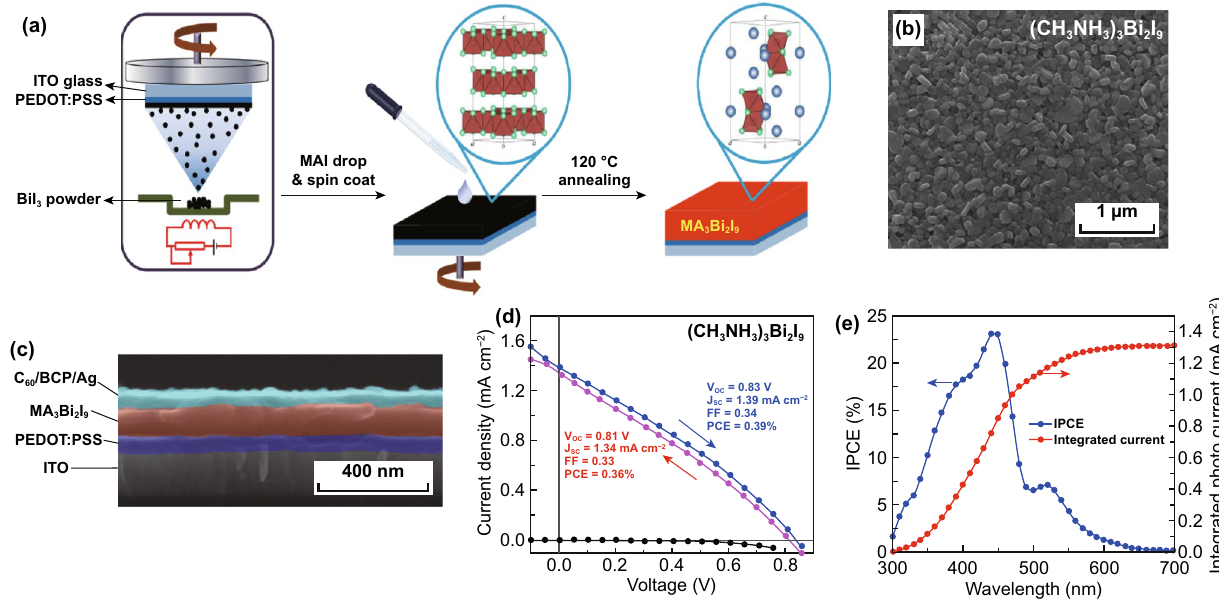
Fig. 13 a Fabrication procedure and b SEM image of (CH 3 NH 3 ) 3 Bi 2 I 9 film. c Cross-sectional SEM image of (CH 3 NH 3 ) 3 Bi 2 I 9 -based solar cells. d Forward and backward scanning and e IPCE spectra of the best-forming device. Reproduced with permission from Ref.